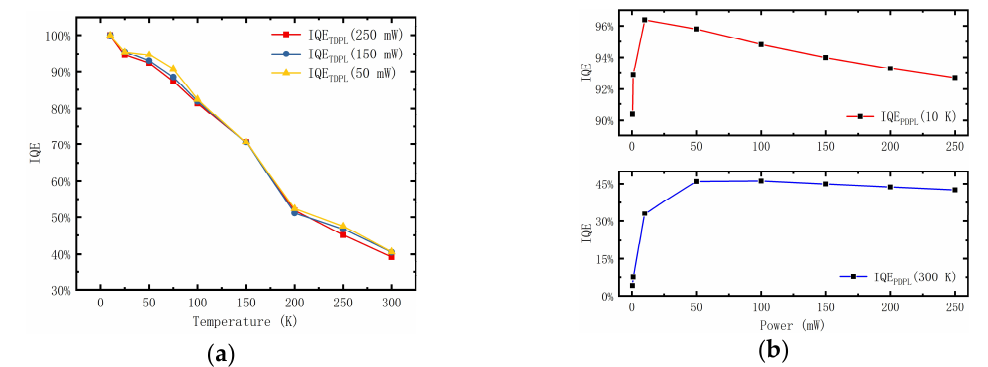
Figure 5. ( a ) The internal quantum efficiency (IQE) values calculated by temperature dependent photoluminescence (TDPL) results at different temperature and three fixed excitation power; ( b ) The IQE values calculated by power dependent photoluminescence (PDPL) results at different excitation power and two fixed temperature.